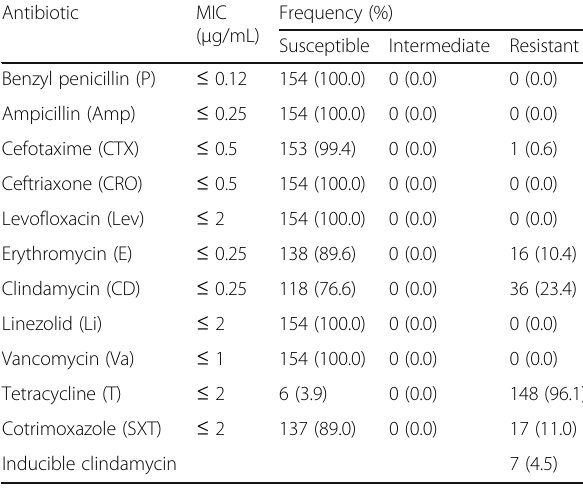
Table 2 Antibiotic sensitivity patterns of GBS isolates